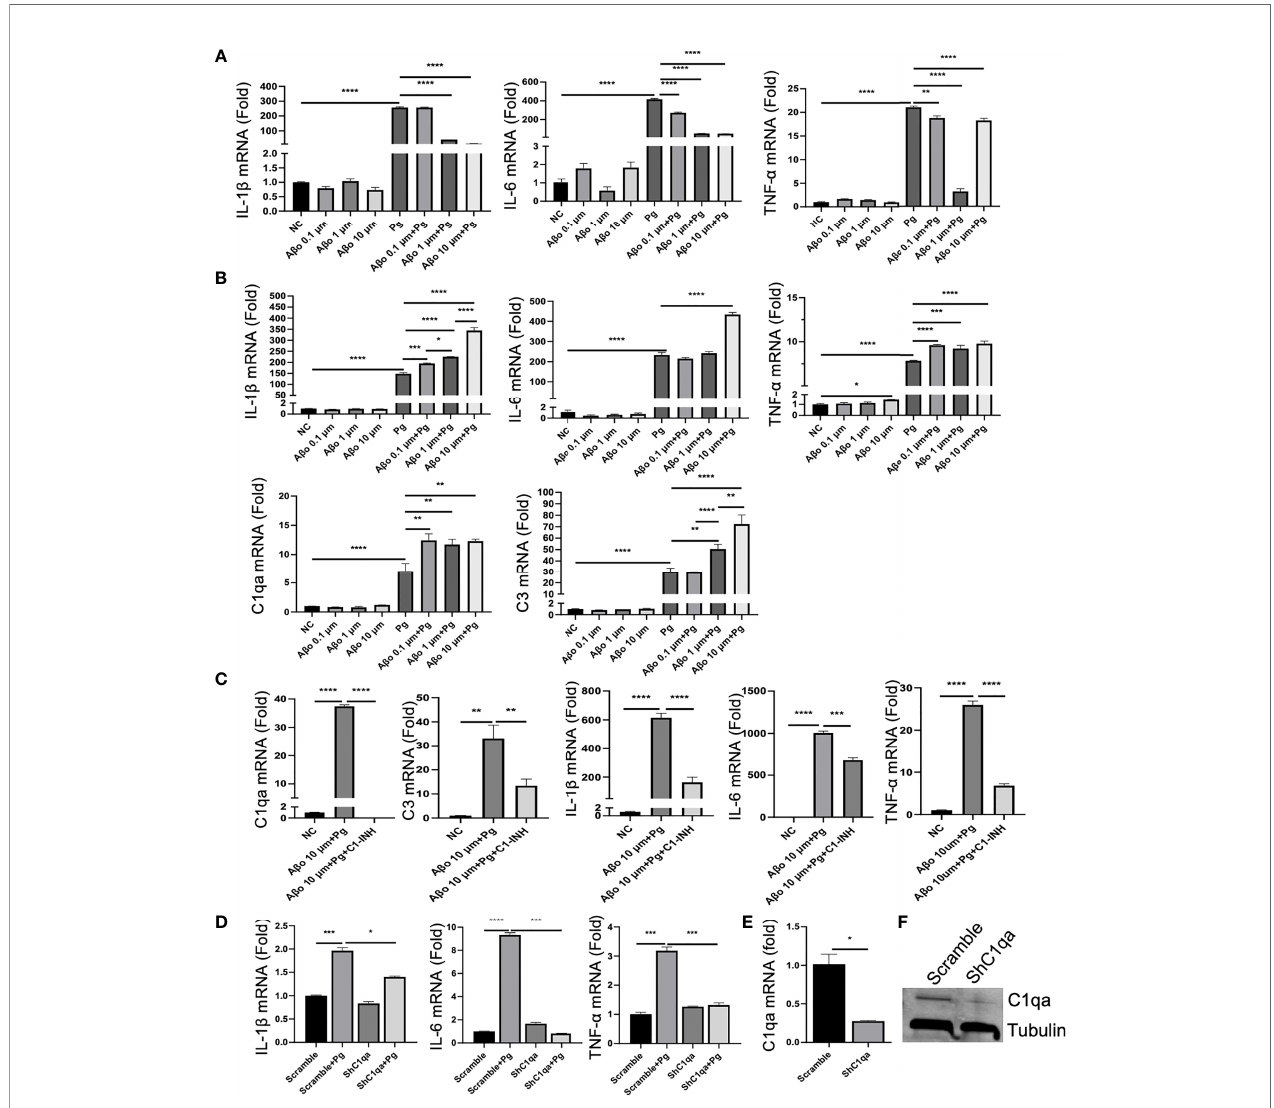
FIGURE 6 | Effect of A b o and complement activation on Pg-induced microglial in fl ammatory responses. (A, B) A b o on Pg-induced cytokine production and complement activation. Primary microglia were treated with A b o (0.1, 1 or 10 µM), Pg (MOI=50), or co-stimulated with A b o and Pg for 24 h (A) , or pretreated with A b o for 6 h followed by Pg stimulation for 24 h (B) . Relative gene expression of IL-1 b , IL-6, TNF- a , C1qa, and C3 was analyzed by RT-qPCR. (C) C1 inhibition on Pg-induced in fl ammatory gene expression by microglia. Primary microglia were untreated or pretreated with C1-INH for 4 h, and then treated with A b o (10 µM) for 6 h followed by Pg (MOI=50) for 24 h. Relative gene expression of C1qa, C3, IL-1 b , IL-6, and TNF- a in microglia were analyzed by RT-PCR . (D) Effect of C1qa depletion on Pg-induced cytokine gene expression by microglia. Primary microglia cells expressing scramble or C1qa shRNA vectors were treated with Pg (MOI=50) for 24 h. Relative gene expression of IL-1 b , IL-6, TNF- a in microglia were analyzed by RT-PCR. Expression of C1qa mRNA (E) and protein (F) in primary microglia veri fi ed by RT-PCR and Western blot. Samples were run in duplicates. Data are expressed as mean ± SEM of three independent experiments; * P < 0.05, ** P < 0.01, *** P < 0.001, **** P < 0.0001 by one-way ANOVA followed with Tukey